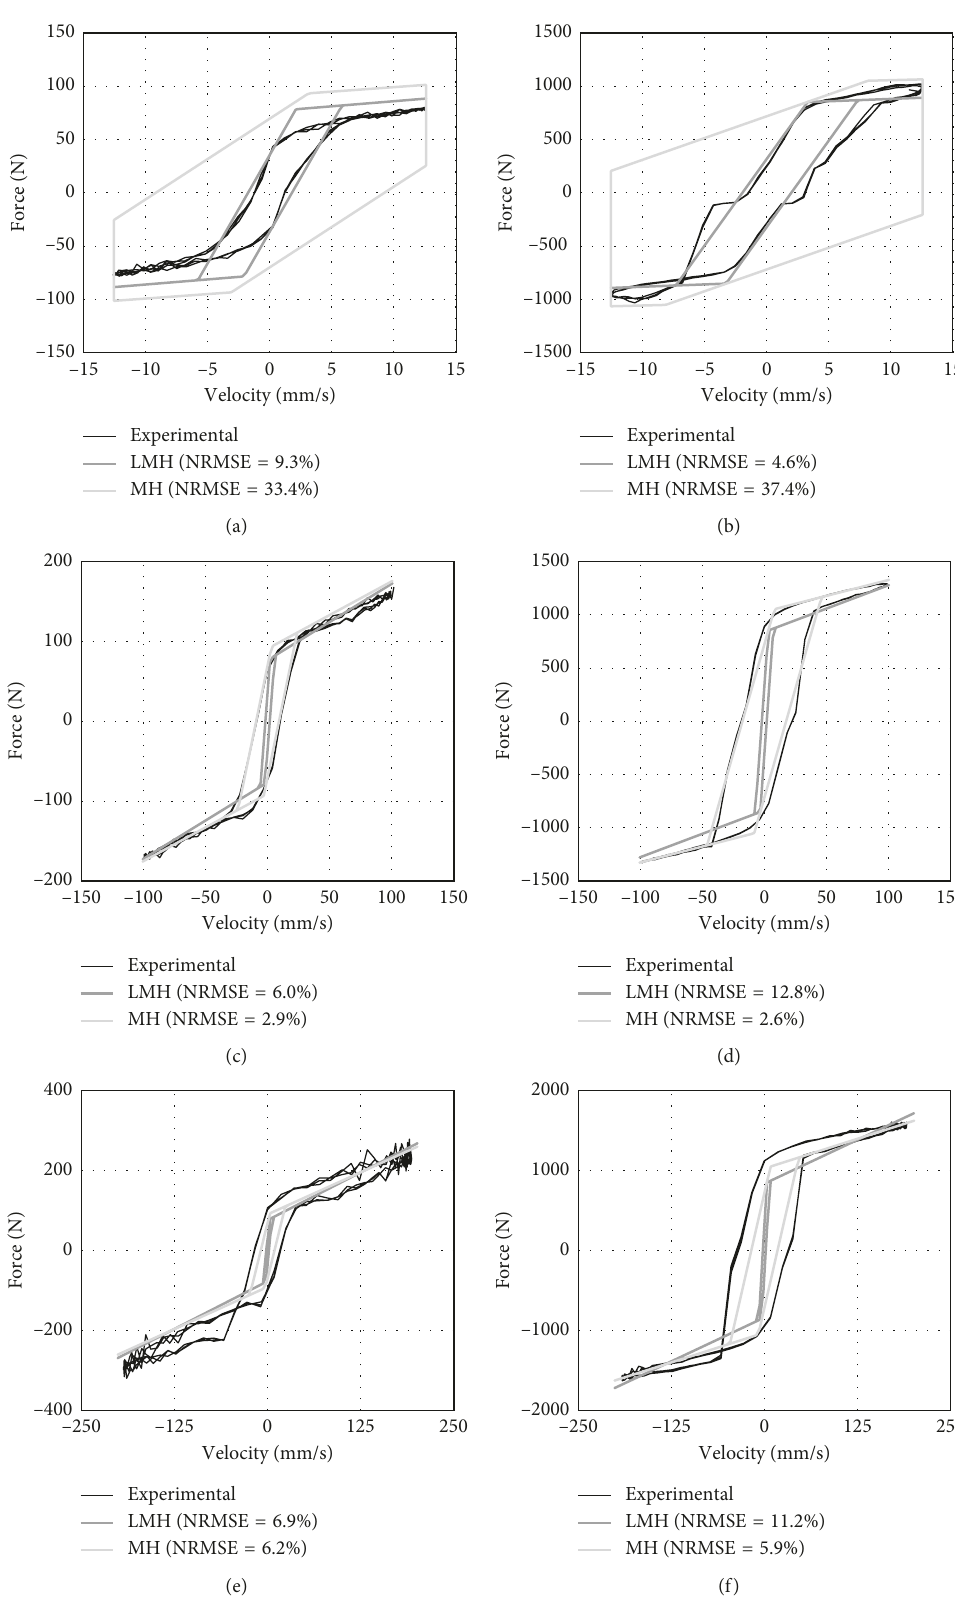
1 A; (e) high velocity without intensity; (f) (cid:31)